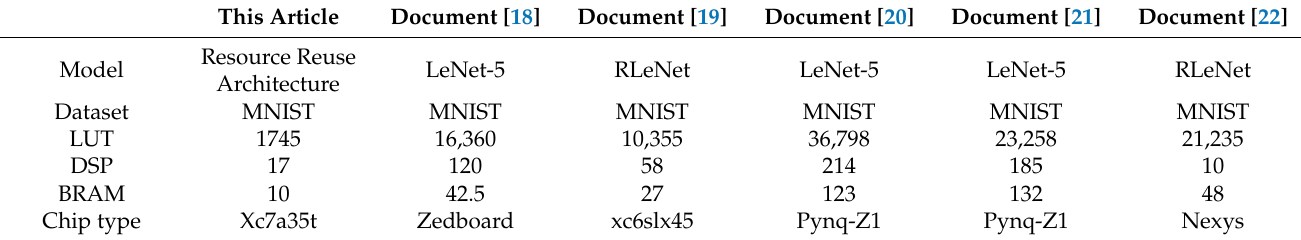
Figure 20. FPGA power consumption. Table 3. Comparison of FPGA Resource Utilization.